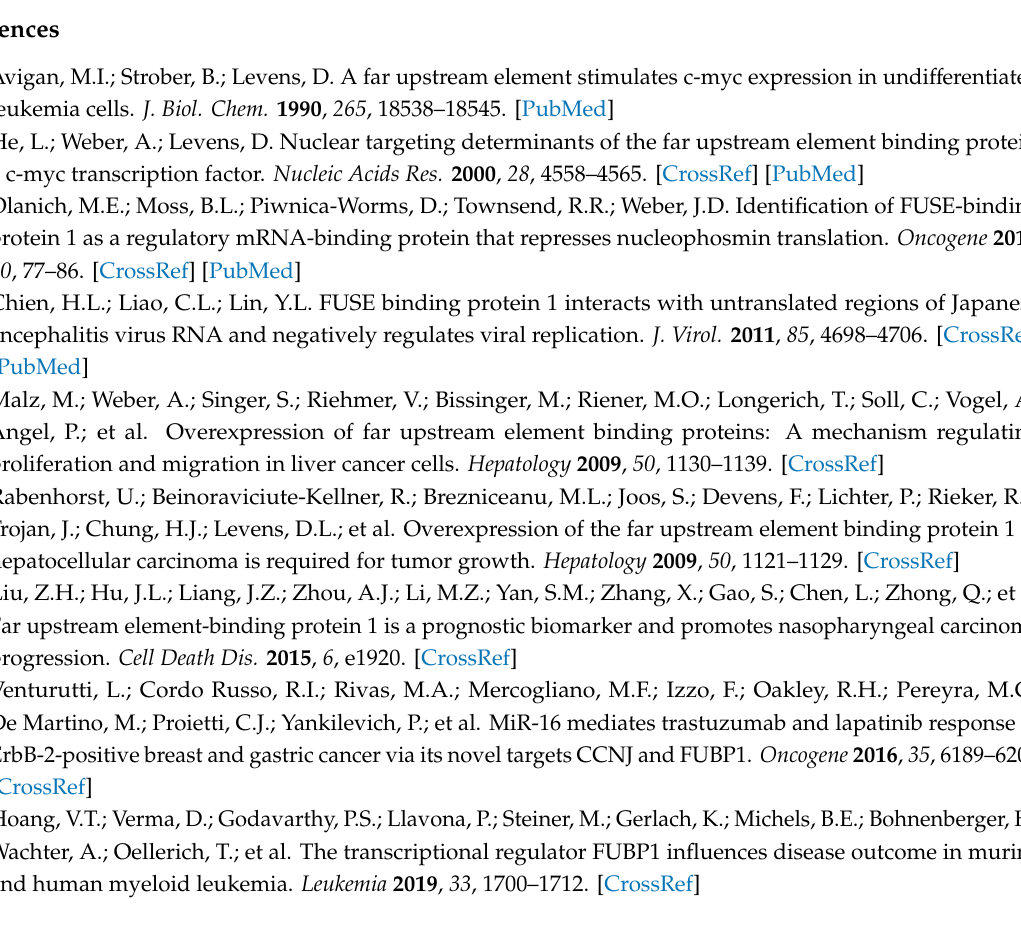
Figure S1. Fubp1 might be involved in cell cycle progression, Figure S2. The interaction between Fubp1 and Ccna1 promoter, Figure S3. Positive correlation between Fubp1 and Ccna1 / Ccna2, Figure S4. Fubpl contributes cell cycle progression and cell survival, Figure S5. Raw western blot